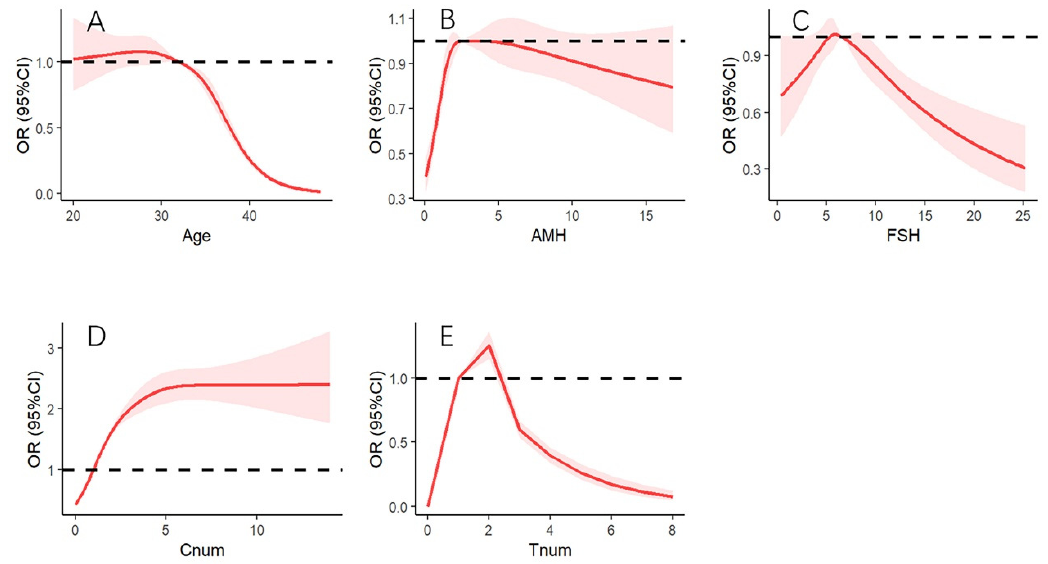
Figure 3. Association of the five factors with CLBR (( A ). Association of age with CLBR; ( B ). Association of AMH with CLBR; ( C ). Association of FSH with CLBR; ( D ). Association of the number of cryopreserved embryos with CLBR; ( E ). Association of the number of total transferred embryos with CLBR). AMH: anti-Müllerian hormone; FSH: follicle-stimulating hormone; Cnum: number of cryopreserved embryos; Tnum: number of total transferred embryos.